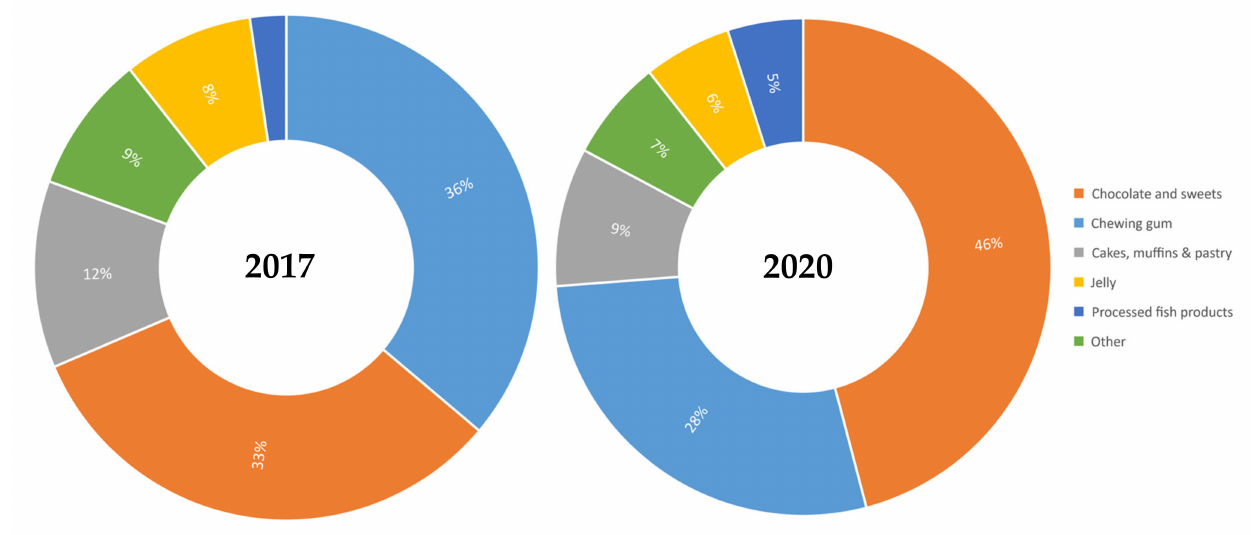
Figure 1. Distribution of foods containing TiO 2 per food (sub)category in 2017 versus